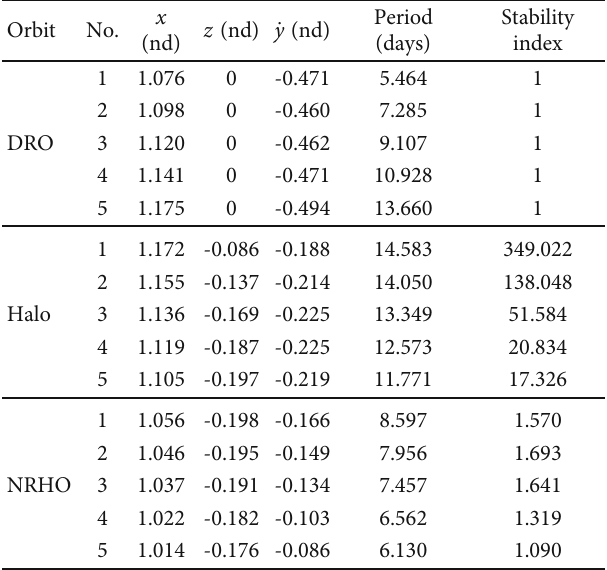
Table 1: The characteristics of the selected nominal orbits in the